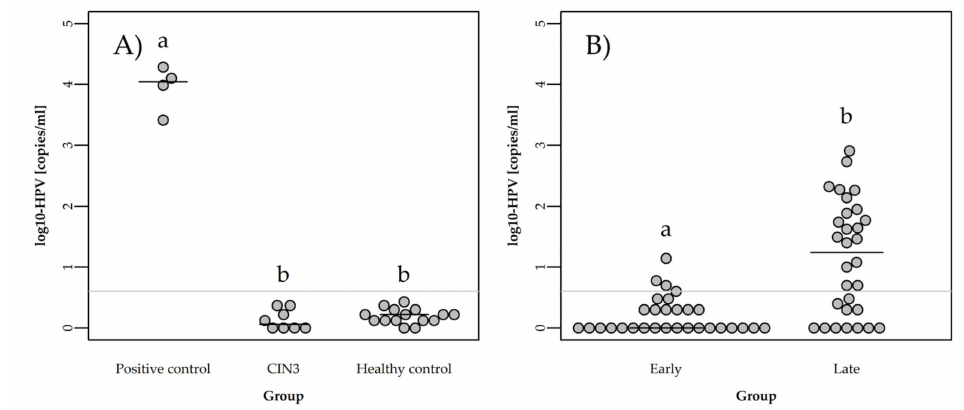
Figure 2. Detection of ccfHPV16/18 DNA by ddPCR in ( A ) four cervical cancer tissue samples (po- sitive control), eight plasma samples from CIN3 patients (CIN3), and 15 plasma samples from healthy individuals (negative control), and in ( B ) plasma samples from the early stage and the late-stage subgroup, respectively. Grey line represents cutoff value for HPV positivity (<3 copies/mL). Different letter (a,b) denote statistically different groups. Black lines represent median